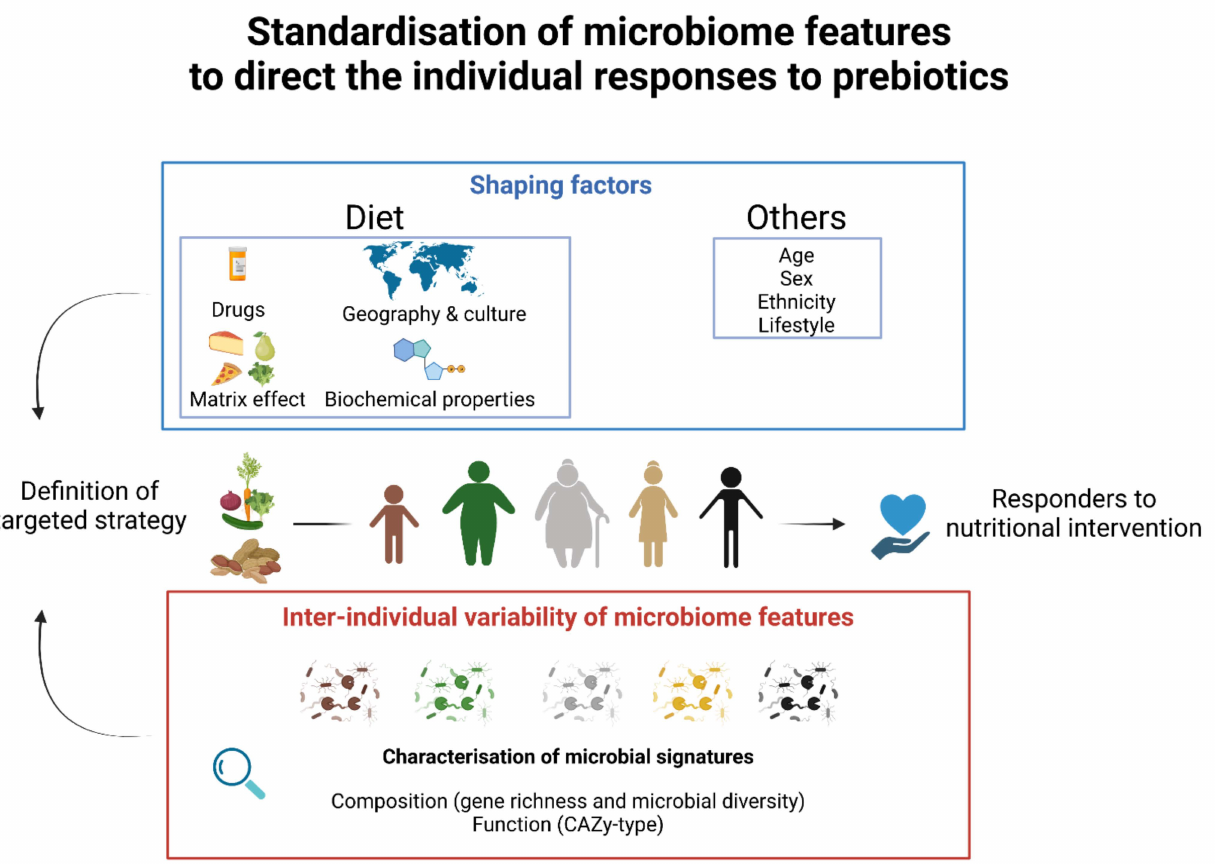
Figure 3. The determination of individual characteristics to direct an efficient prebiotic intervention. Individual and environmental shaping factors and interindividual variability of microbiomes mod- ulate differential clinical responses to prebiotics. The description of microbiome signatures at the compositional and functional levels can provide insights to define a targeted nutritional strategy. A standardisation of multi-criteria aims to match the prebiotic intervention with individuals that would likely respond